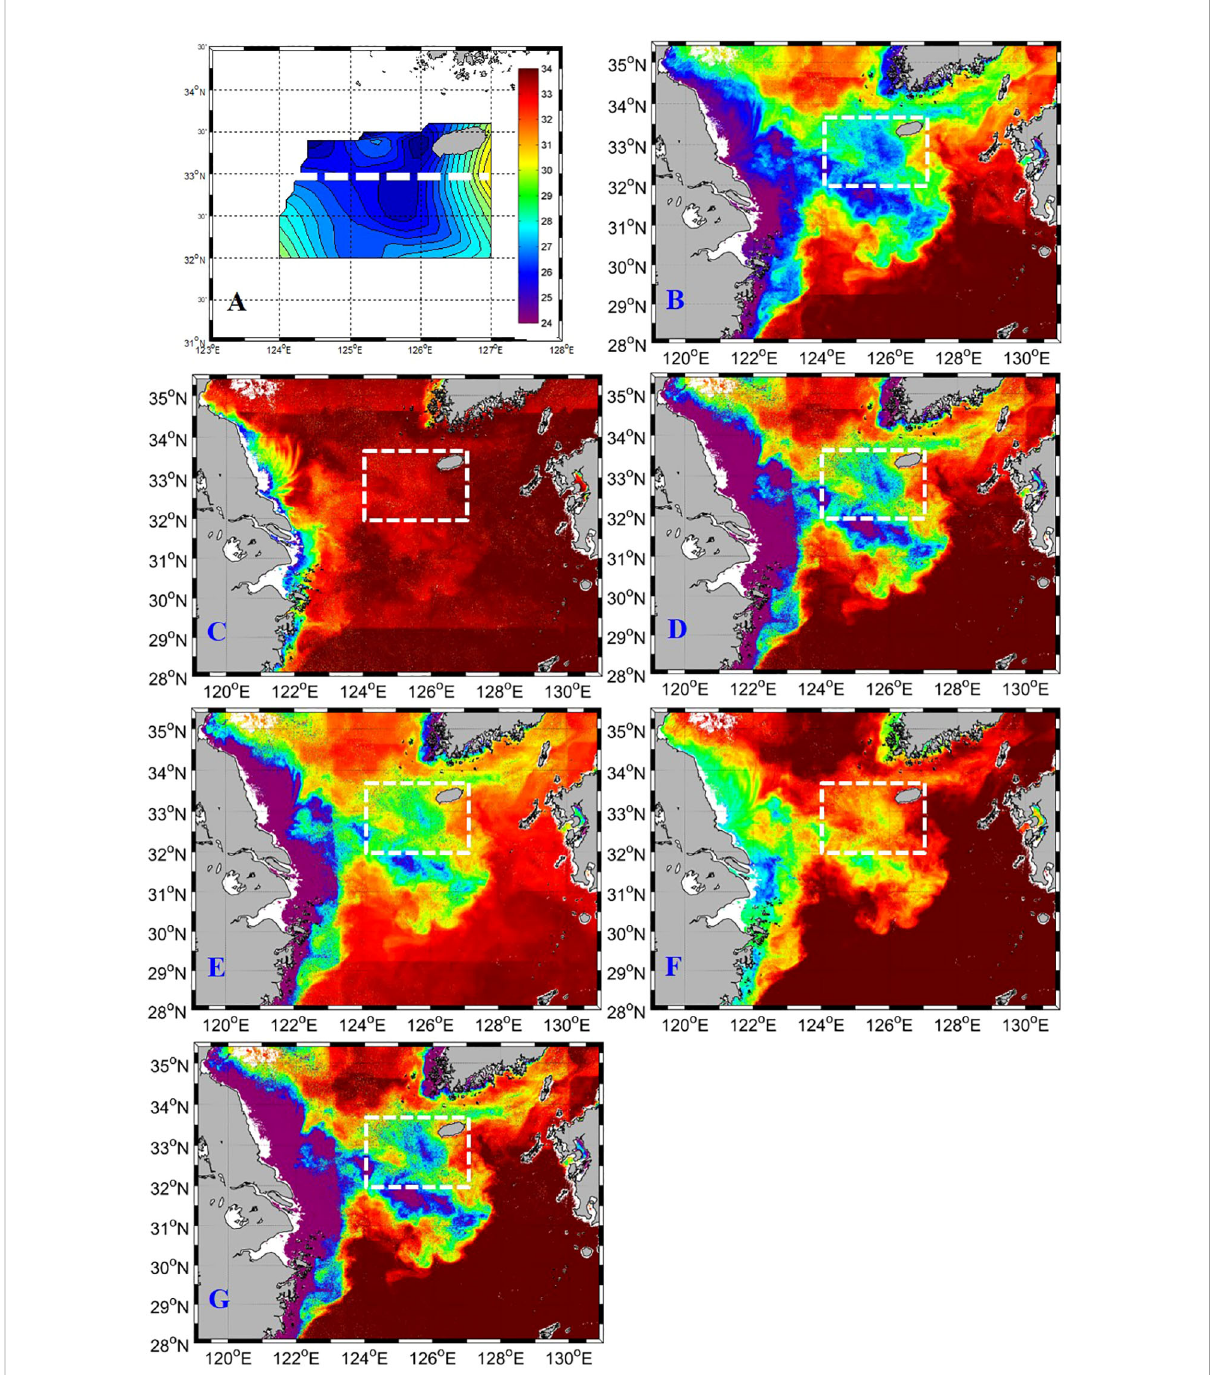
FIGURE 6 (A) Sea surface salinity (psu) calculated from CTD data obtained during the period 16 – 19 August 2016. (B – G) Satellite images from which salinity (psu) was calculated using the (B) proposed two-step approach (Eq. 4), as well as the methods of (C) Binding and Bowers (2003), (D) Ahn et al. (2008), (E) Sasaki et al. (2008), (F) Son et al. (2012), and (G) Bai et al. (2013). Data obtained during a 4-day cruise were